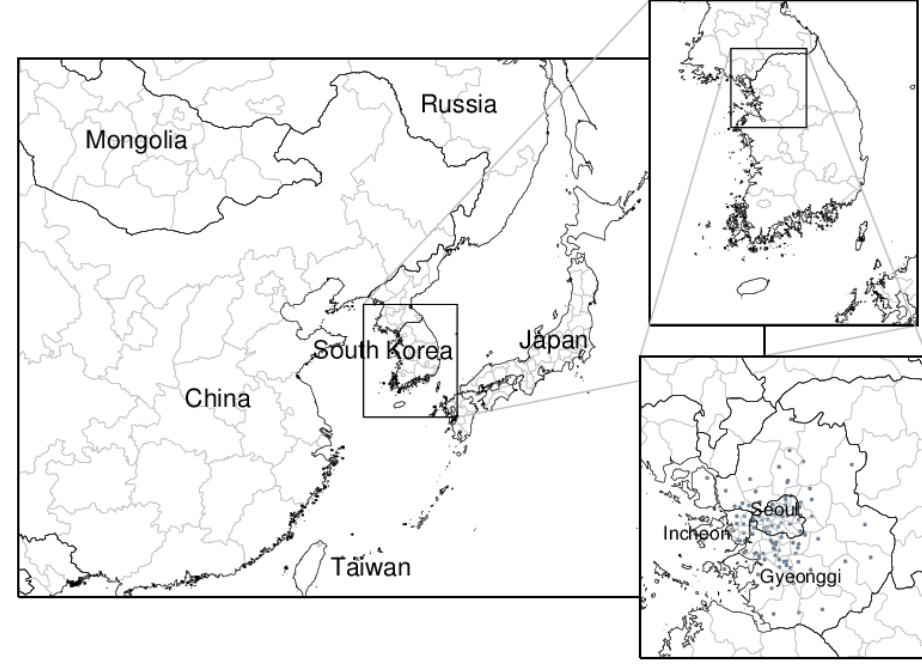
Figure 1. Geographical extent of study domain: East Asia, South Korea, and the SMA.